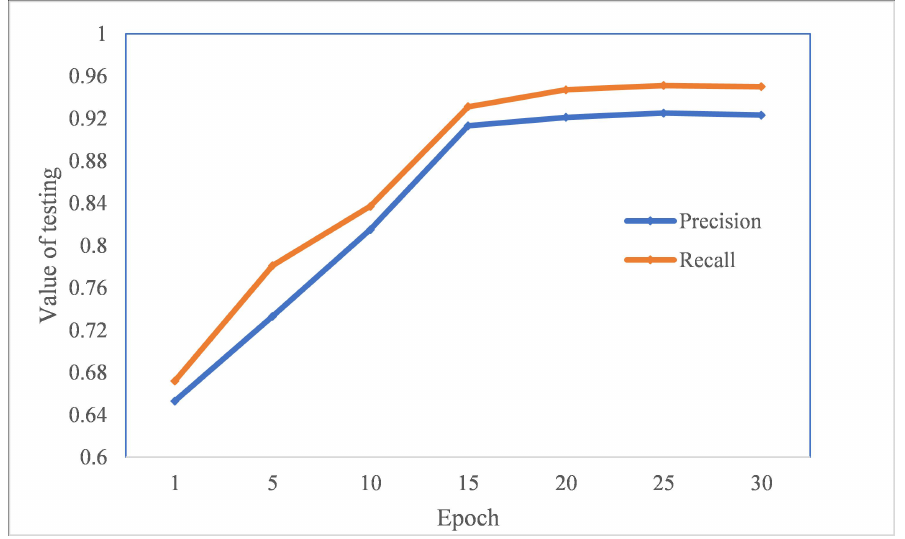
Figure 6. Variation of precision and recall. Table 5. Experimental results from the company’s private data. The bold numbers are the best results.